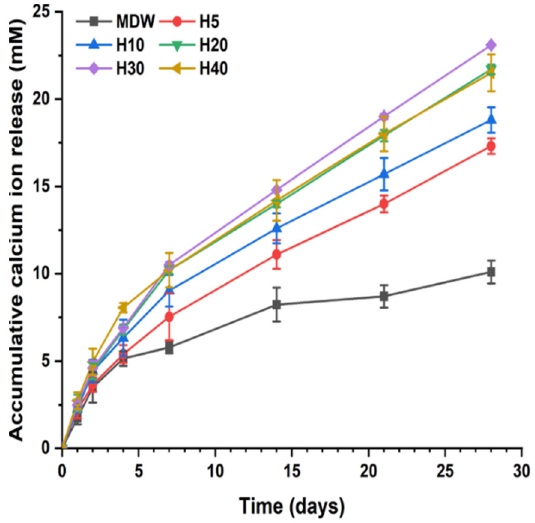
Figure 1. Calcium ion release of each experimental group in distilled water over 28 days. The calcium ions of the experimental group were proportionately released from days 7 to 28 in contrast to the MDW group.